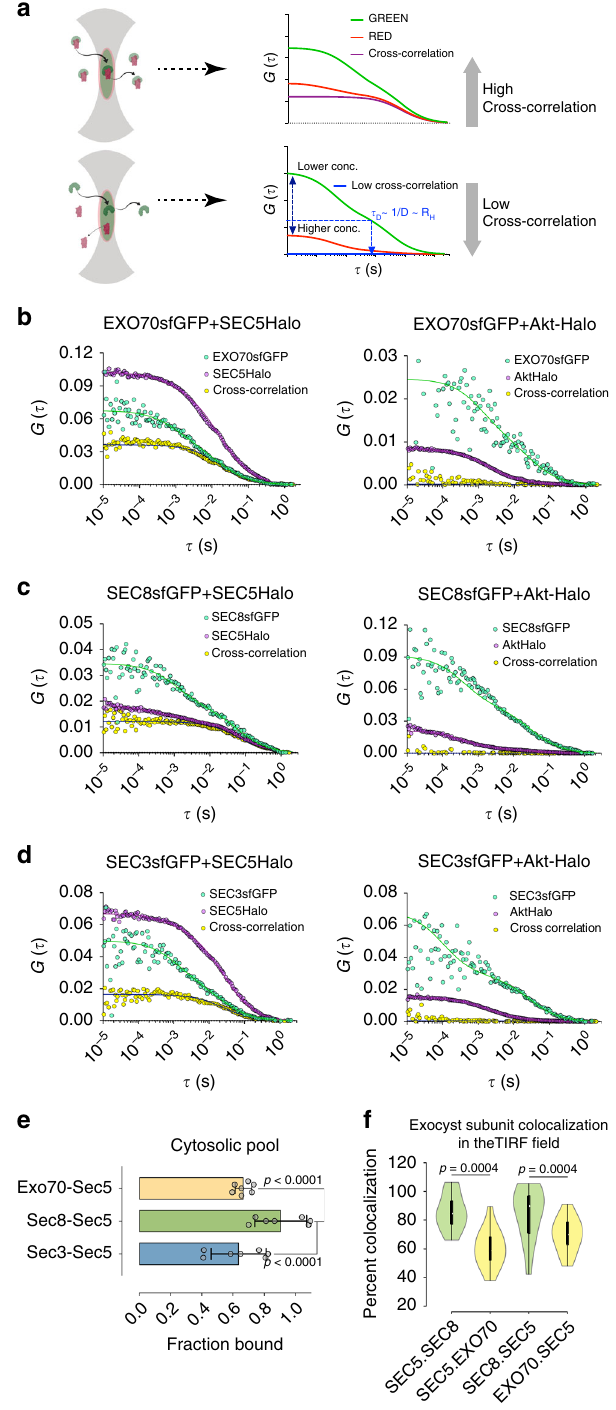
Fig. 6 Dual-color FCCS of exocyst subunits in the membrane and cytosol. a Schematic of dual-color cross-correlation spectroscopy (FCCS). Top diagram shows cross-correlation between co-diffusing molecules. Bottom shows molecules that do not co-localize. b SEC5-Halo and EXO70-GFP FCS measurements in the cytosol and the PM. EXO70-GFP and Akt-Halo fl uorescence cross-correlation was used as a negative control. HaloTag was labeled using JF646 Halo ligand (200 nM for 1.5 h). c SEC5-Halo and SEC8- GFP, or SEC8-GFP and Akt-Halo FCS measurements in the cytosol or the PM. d SEC5-Halo and SEC3-GFP, or SEC3-GFP and Akt-Halo FCS measurements in the cytosol or the PM. e Statistics of the fraction of GFP- tagged exocyst subunit bound in the cytosol. SEC8-GFP + SEC5-Halo: 92 ± 3.86%, SEC3-GFP + SEC5-Halo: 67 ± 3.84%, and EXO70-GFP + SEC5-Halo: 64 ± 3.46% (mean ± SEM). f Fractional coincidence between SEC5-Halo and SEC8-GFP or SEC5-Halo and EXO70-GFP was analyzed using TIRFM. Calculations were corrected for HaloTag labeling ef fi ciency and expression levels of SEC8-GFP and EXO70-GFP with respect to SEC5-GFP. Center line denotes median. SEC5-Halo bound to SEC8-GFP was 85 ± 3.3% (mean ± SEM). SEC8-GFP bound to SEC5-Halo was 85 ± 5.1%. SEC5-Halo bound to EXO70-GFP was 60 ± 3.2% and EXO70-GFP bound to SEC5-Halo was 69.8 ± 2.9%. Object detection parameters were set between 0.30 and 0.35 µ m and contrast was adjusted to faithfully detect objects of interest. White circles show the medians; box limits indicate the 25th and 75th percentiles as determined by R software; whiskers extend 1.5 times the interquartile range from the 25th and 75th percentiles; polygons represent density estimates of data and extend to extreme values. p values were calculated using Kruskal – Wallis test followed by Dunn ’ s multiple comparison test. The hydrodynamic radius (R H ) for the slow diffusing fraction was median 466 nm (95% CI: 355.2 – 606.8), and that of the fast diffusing component, 14.82 nm (95% CI: 13.22 – 17.27). FCS measurements were fi tted (lines) to the model described in Methods (Eqs 2 – 4). Curves shown are representative, taken from a single cell. Statistics are average from > 25 measurements for each condition from two experiments and > 5 cells. p- values were calculated by one-way ANOVA followed by Tukey ’ s post hoc